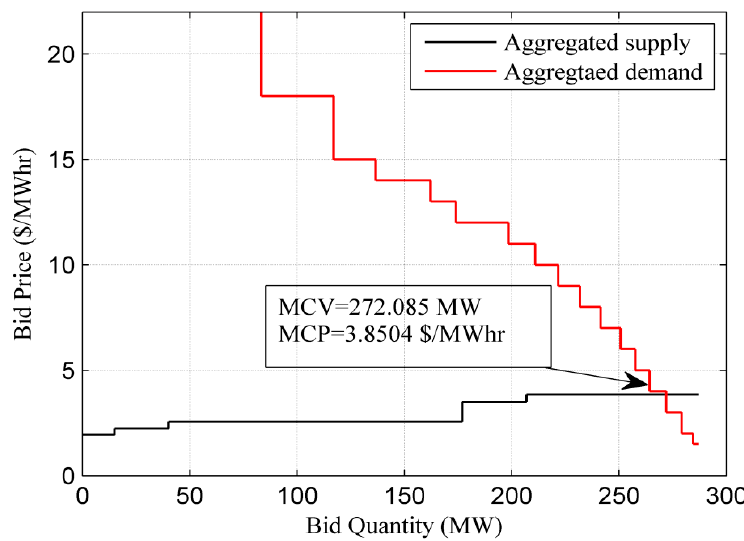
Figure 6. Market clearing simulation without considering joint WF and PHS system.